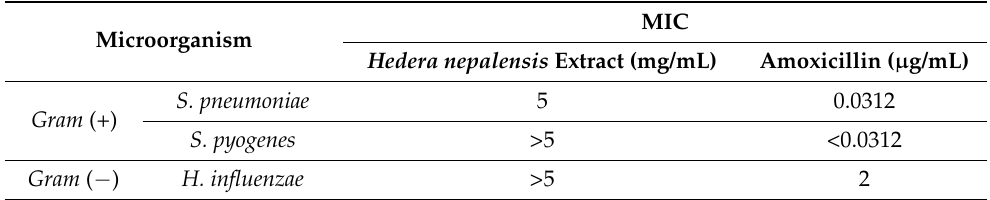
Table 5. MIC values of the extracts from H. nepalensis leaves for several strains of bacteria related to respiratory